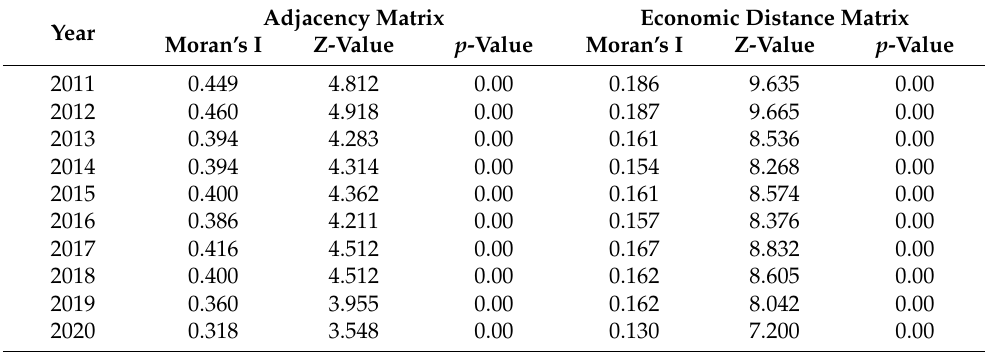
Table 6. Data stationarity test.